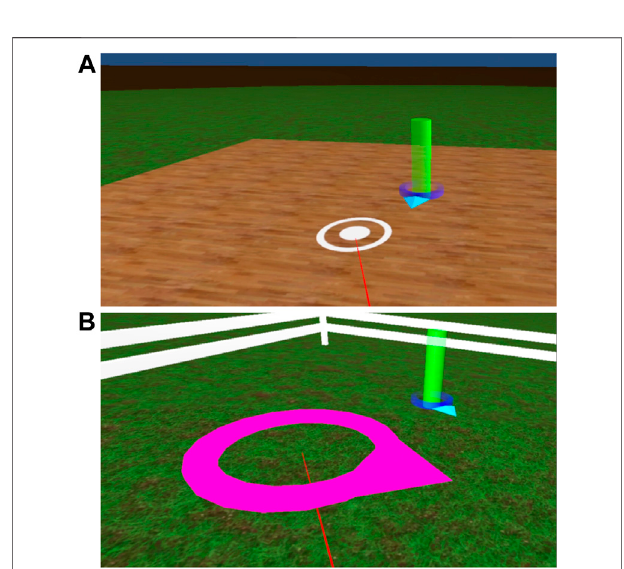
FIGURE2|(A) :Tousethe partiallyconcordantteleporting interface, the participant positioned the concentric white circles to match the position of the post. (B) : To use the discordant teleporting interface, the participant positioned and oriented the magenta ring to match the position and orientation of the green post and the arrow at the base of the